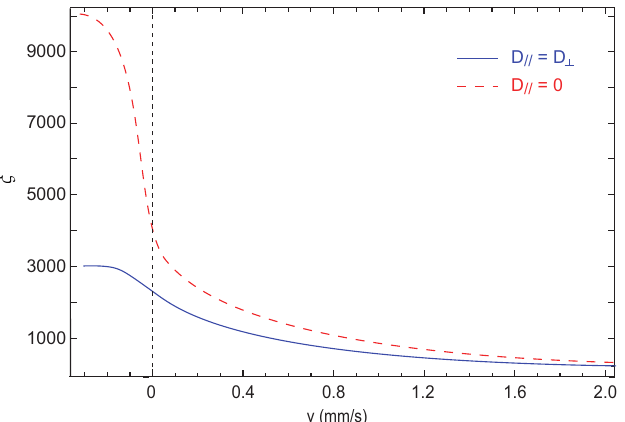
Figure 7. Dimensionless drag coefficient ξ predicted for an elementary edge dislocation in 8CB at 30 ◦ C as a function of velocity v (adapted from Ref. [28], with kind permission of the European Physical Journal).